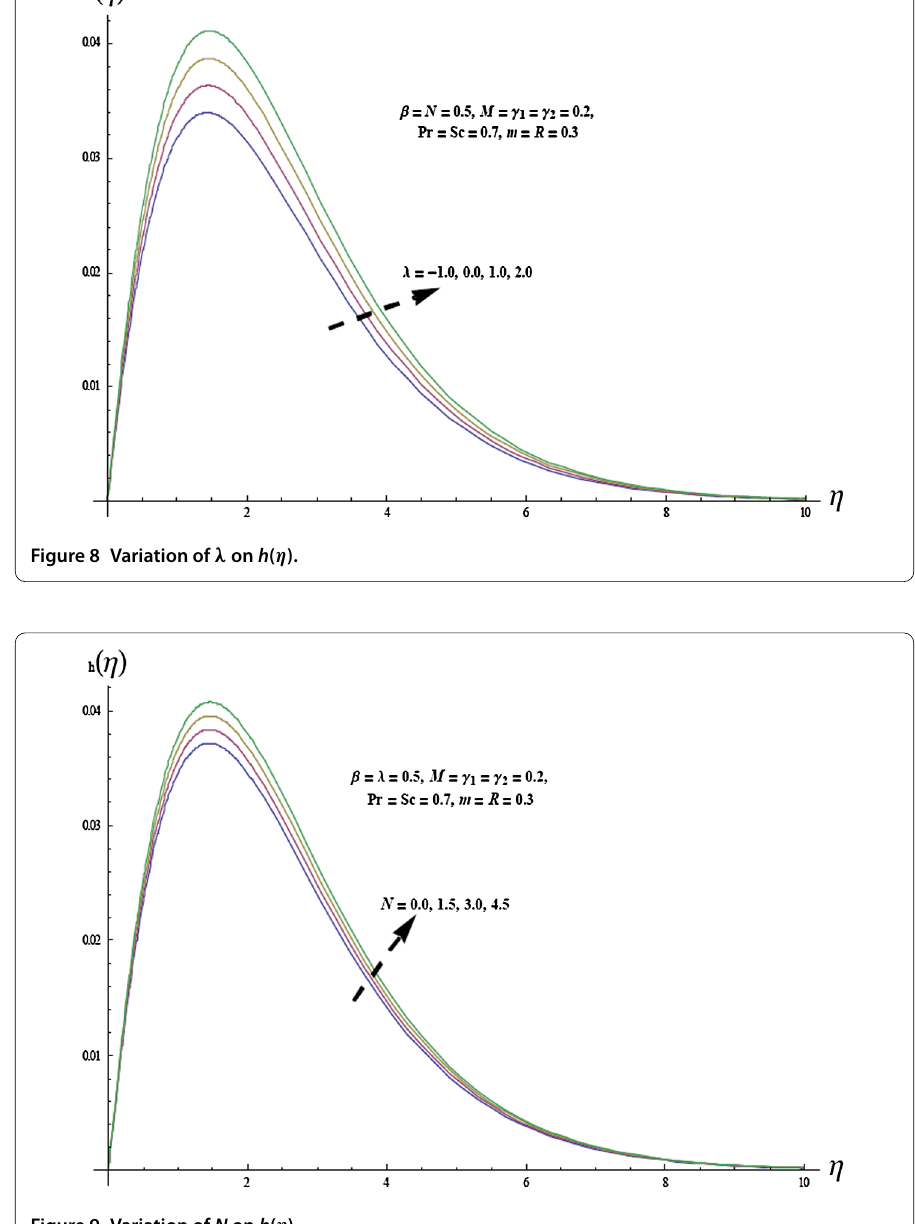
Figure 9 Variation of N on h ( η